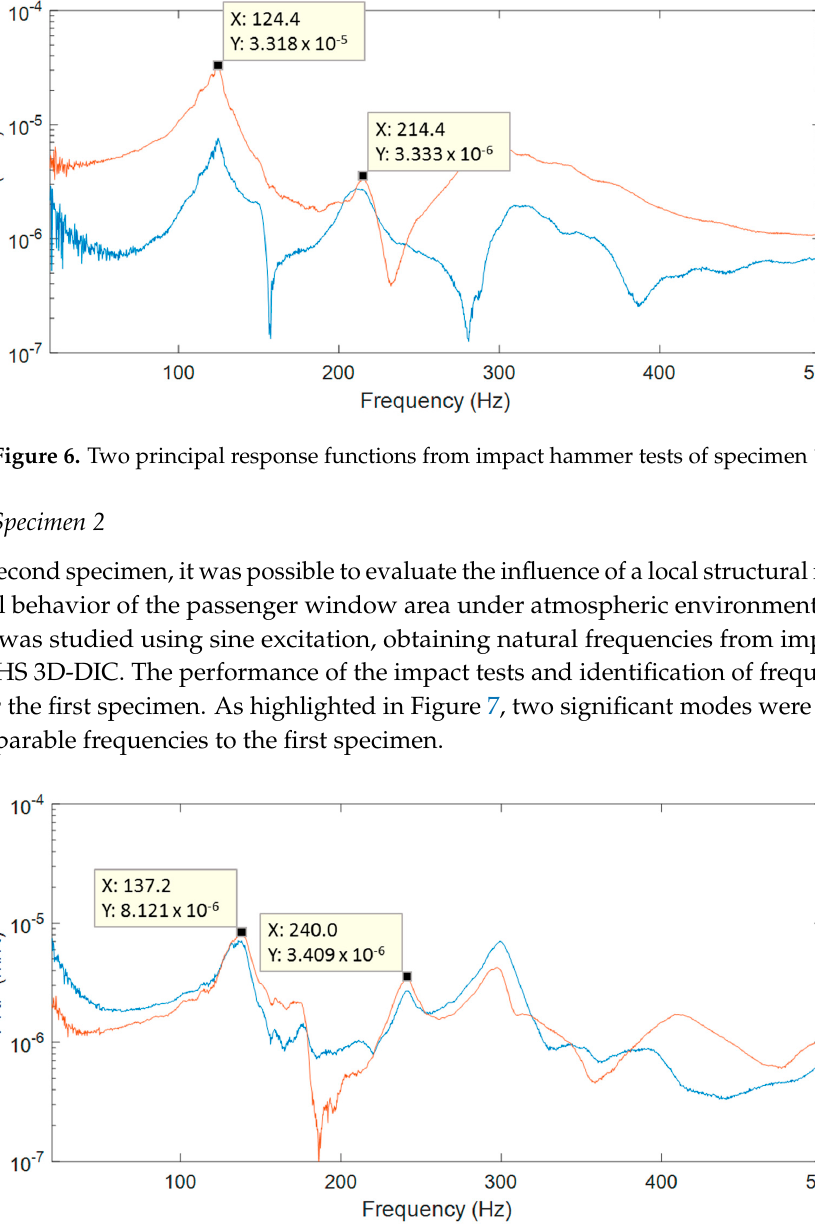
Figure 5. Set-up for impact hammer tests on the passenger window of the GRA front fuselage demonstrator (exterior view).